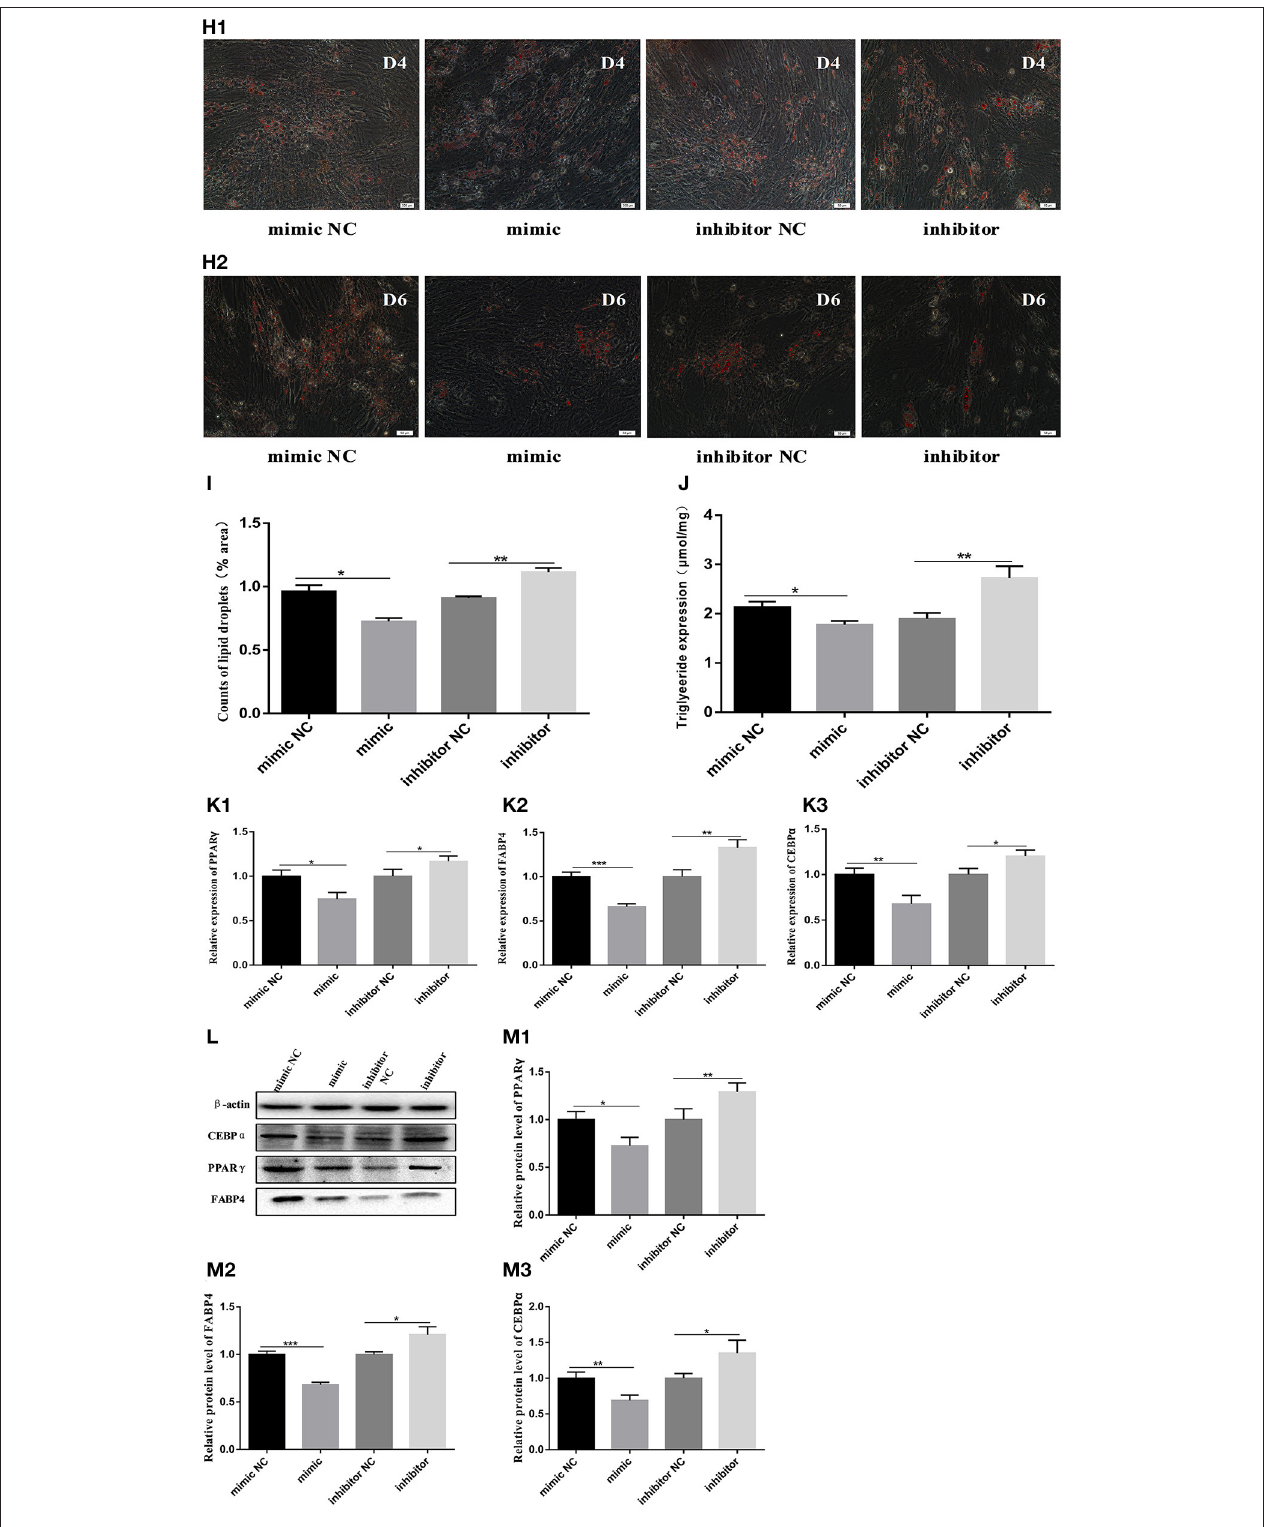
FIGURE 3 | Differentiation of pre-adipocytes from Qinchuan cattle. (A) Background expression of bta-miR-150 on different days after inducting differentiation in Qinchuan cattle adipocytes. (B) bta-miR-150 mimic transfection efficiency. (C) bta-miR-150 inhibitor transfection efficiency. (D) Overexpression of